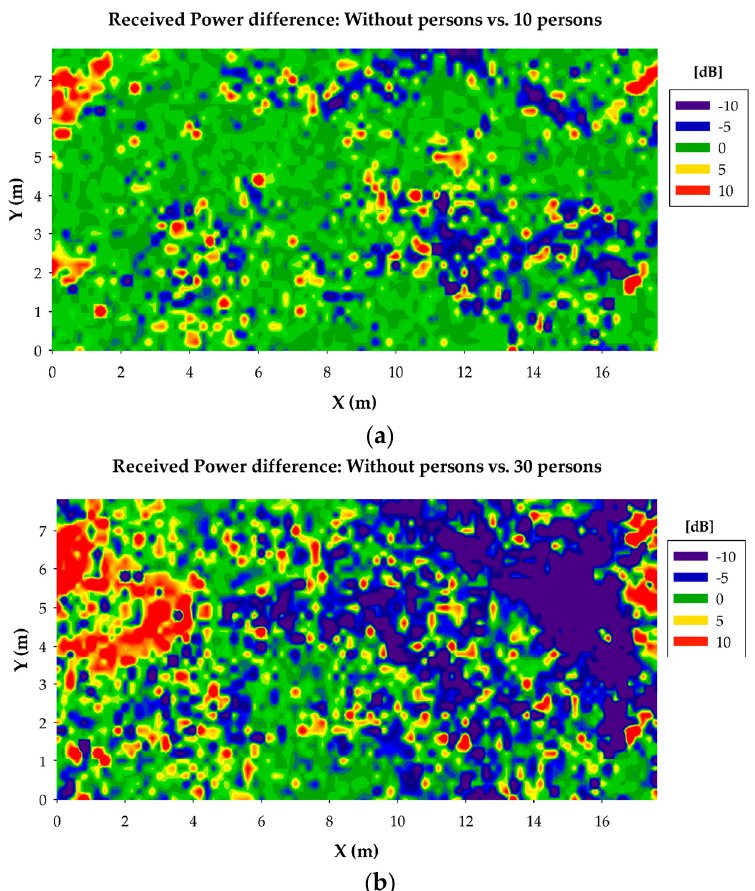
Figure 13. Received power level difference for the bidimensional plane at 0.8 m height between the results without persons and ( a ) with 10 persons; ( b ) with 30 persons.